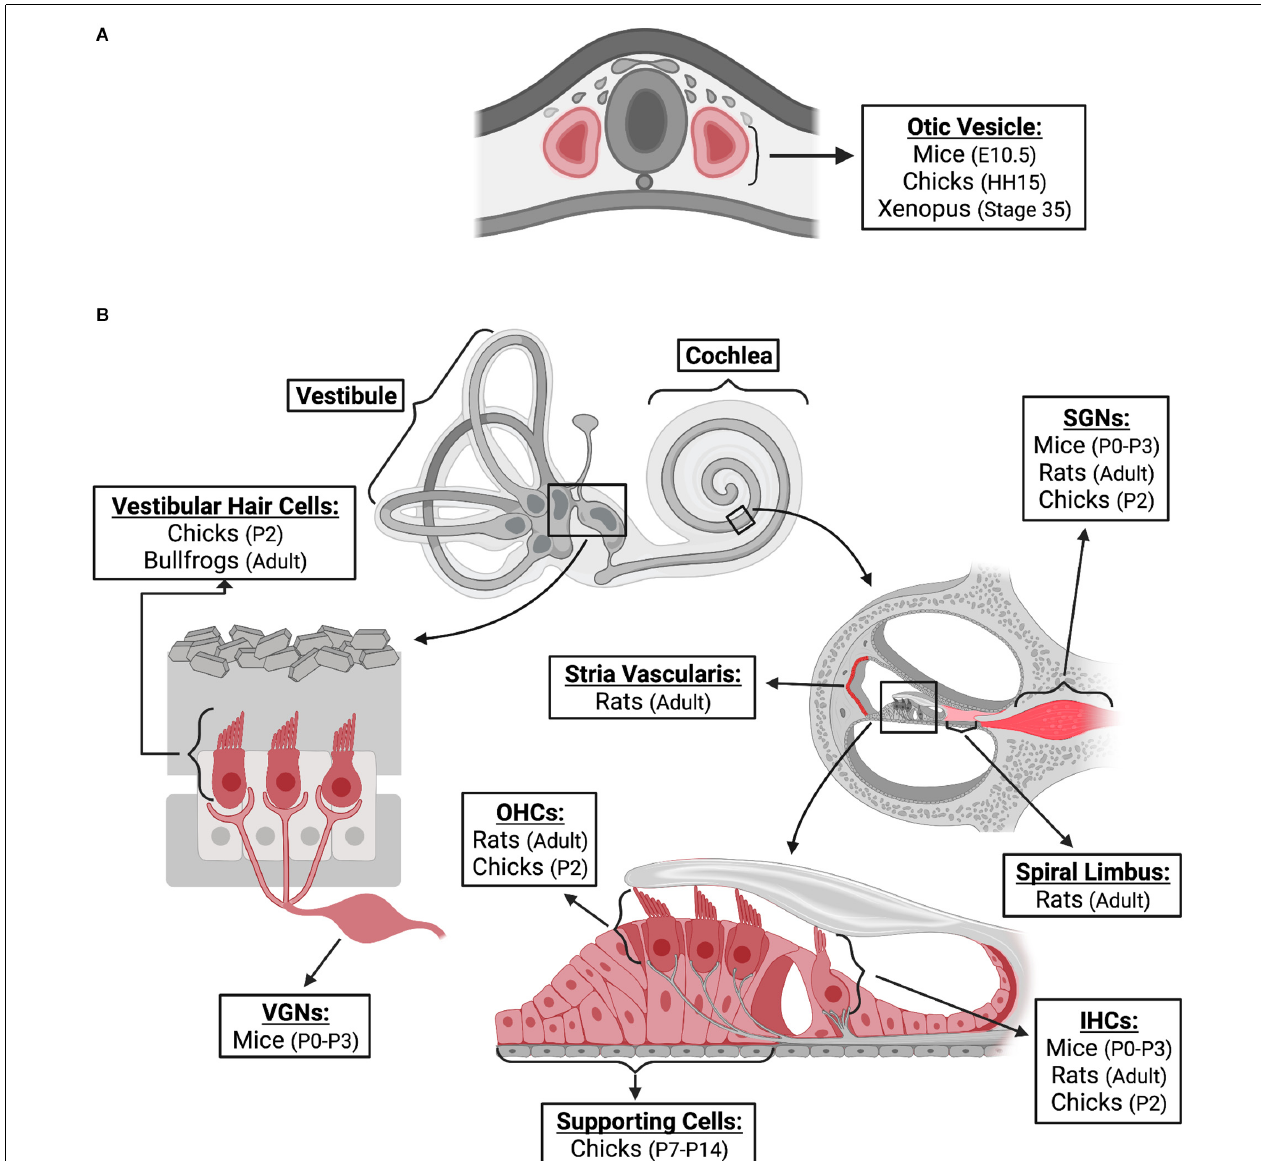
FIGURE 1 | FGF2 expression in inner ear. FGF2 expression locations are indicated in red. The species, and age at which expression was confirmed, are provided for different locations of the inner ear during embryonic development (A) and post-natal (B) stages. Locations of expression are also provided for non-mammalian models; however, the depiction is based on similar structures of the mammalian inner ear. FGF2, fibroblast growth factor 2; E, embryonic; HH, hamburger-hamilton; P, post-natal; VGNs, vestibular ganglion neurons; SGNs, spiral ganglion neurons; OHCs, outer hair cells; IHCs, inner hair cells. Created with BioRender.com.